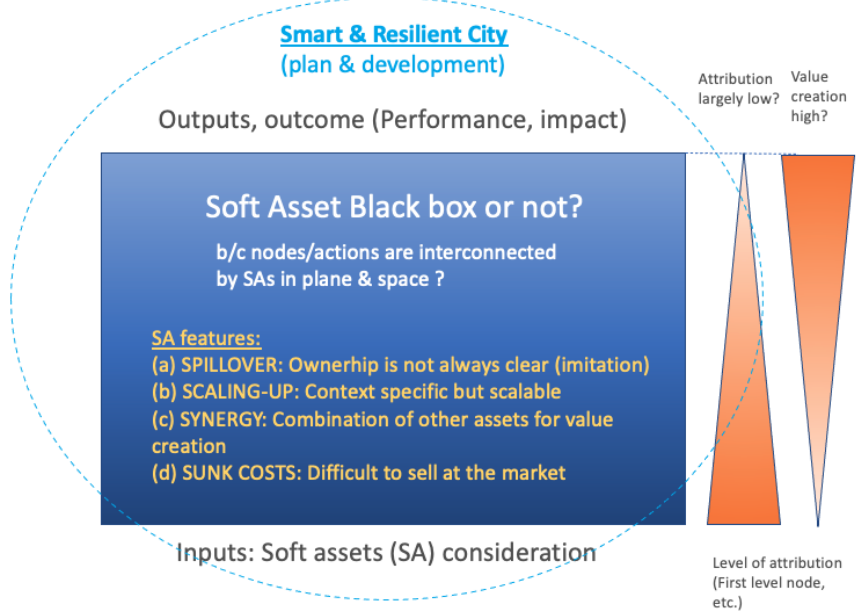
Figure 1. Soft assets in smart and resilient